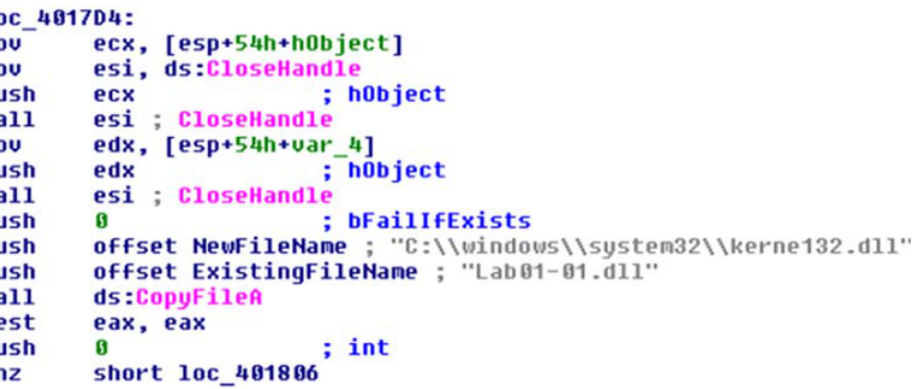
Figure 3. Interactive DisAssembler (IDA Pro) dissembling an executable file. 219